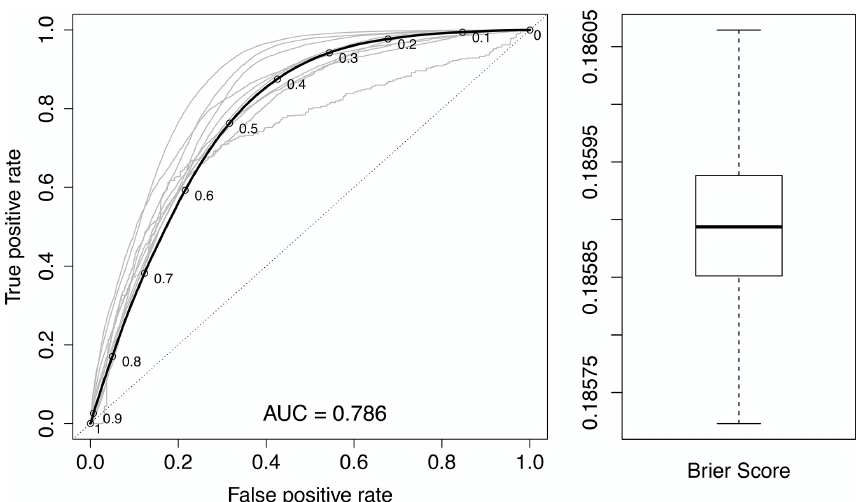
Figure 10. On the left-hand side, the ROC curve is displayed with the AUC value for the all-in-one model in black (including locations of probability thresholds) superimposed over the individual-site models in grey. On the right-hand side is the bootstrapped Brier score for the all-in-one model.